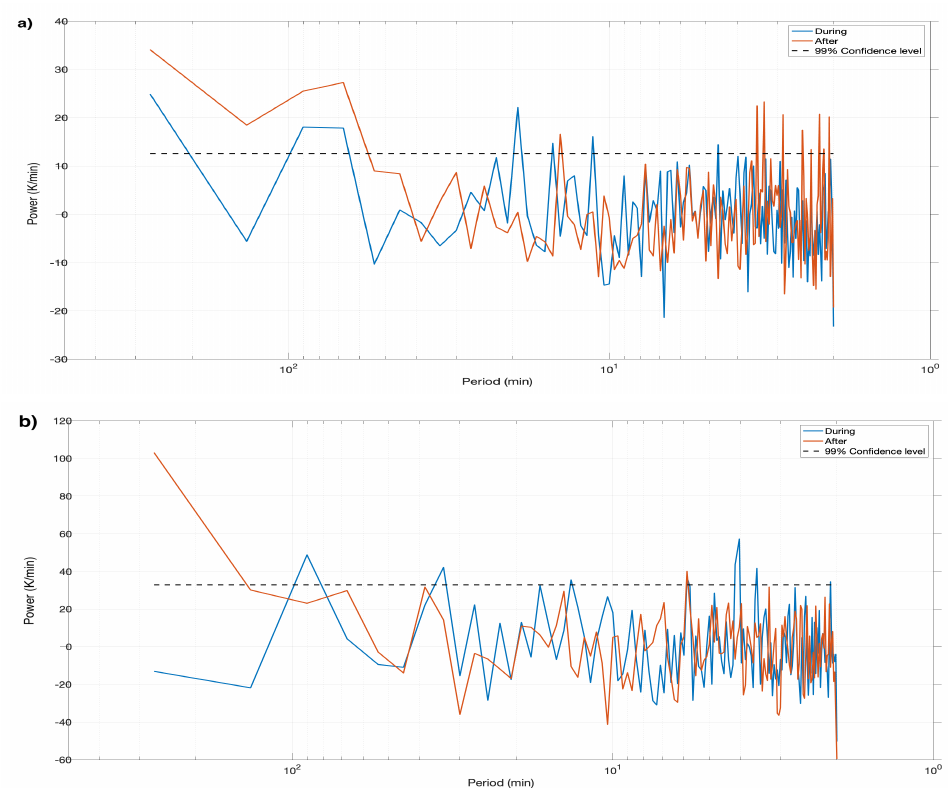
Figure 12. ( a ) Mean Fourier spectra of lidar data before and after midnight for the altitude range [42–48] km. ( b ) Mean Fourier spectra of lidar data before and after midnight for the altitude range [50–58]